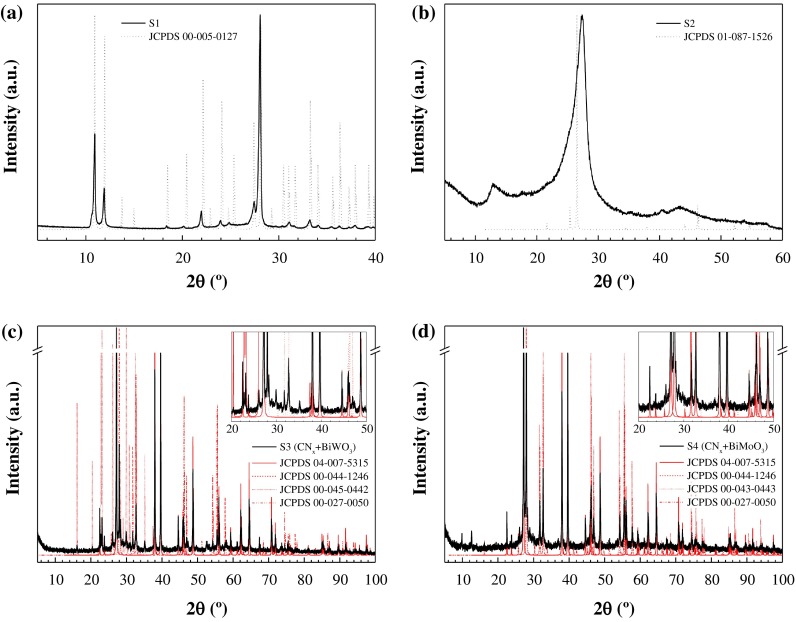
X-ray powder diffraction patterns of: (a) Ccoke/melamine cyanurate (S1), (b) Ccoke/g-C3N4 (S2), (c) Bi/Bi2WO6/g-C3N4 (S3), and (d) Bi/Bi2MoO6/g-C3N4 (S4) composites. JCPDS patterns have also been included for comparison purposes.